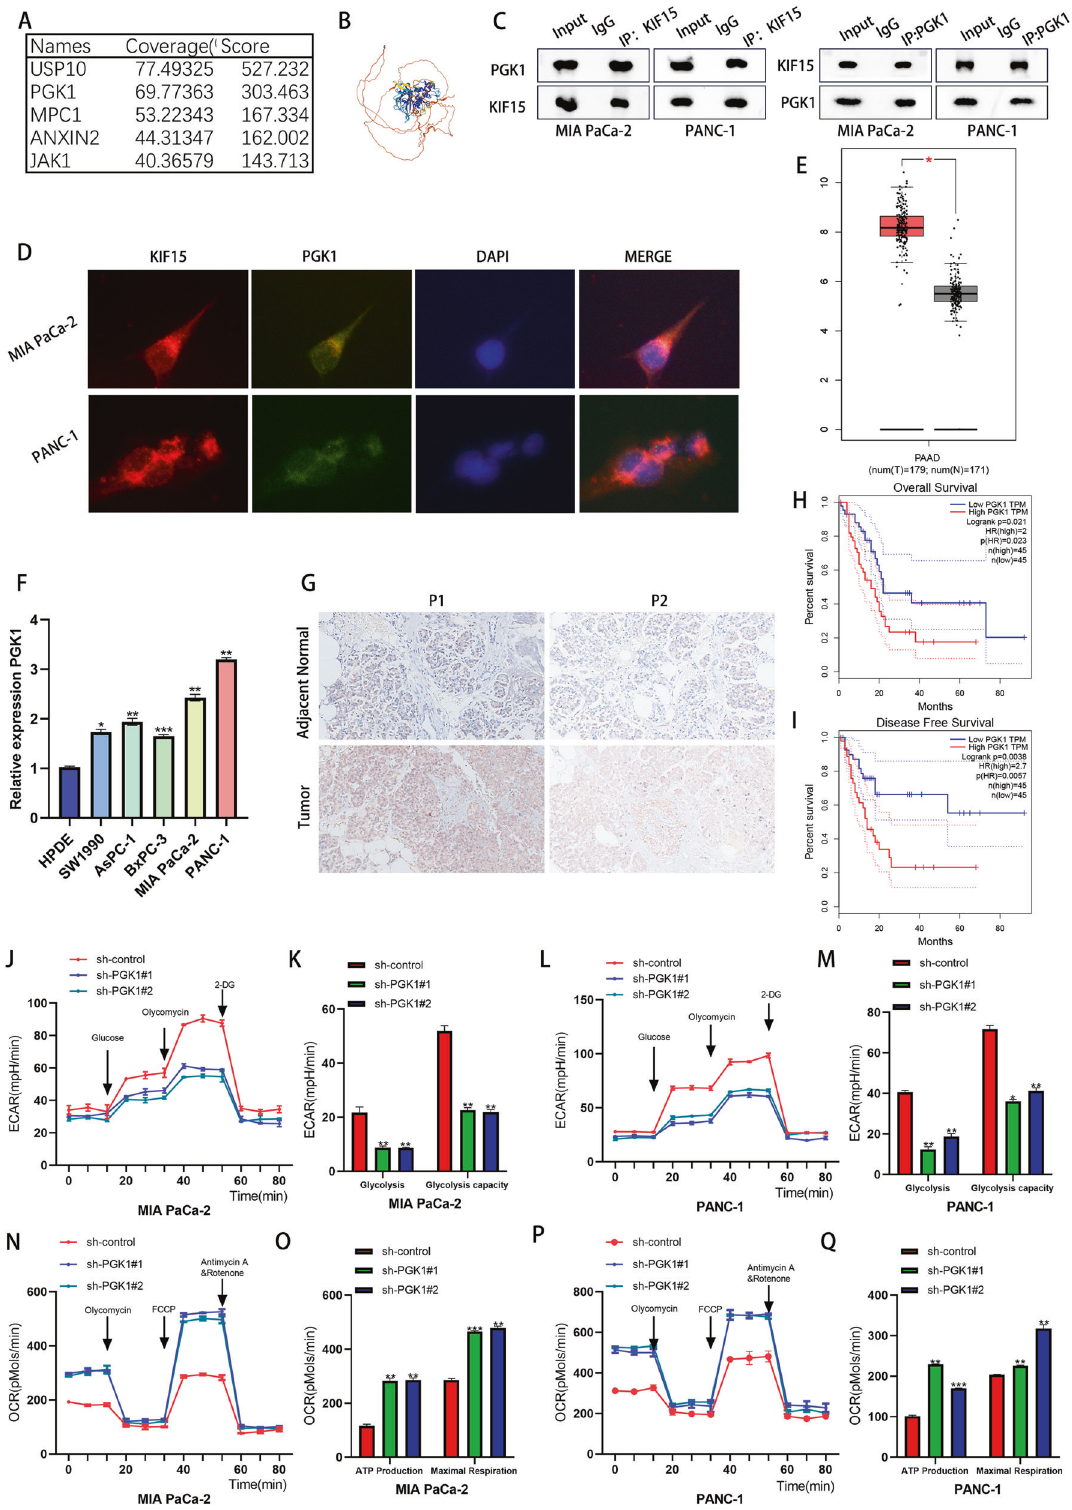
Fig. 4 KIF15 interacted with PGK1. A The mass spectrum showed the possible binding proteins of KIF15. B The predicted construction of PGK1 by bioinformatic tools (https://alphafold.ebi.ac.uk/). C The reciprocal co ‐ immunoprecipitation assay between PGK1 and KIF15. D The immuno fl uorescence between KIF15 (red) and PGK1 (green). E The expression of PGK1 in TCGA-PAAD dataset. F The relative expression of PGK1 mRNA in PC cells and normal pancreatic cells. G The IHC staining of PGK1 in PC patient tissues. n = 10. H The overall survival of patient in PGK1-low or PGK1-high expression group. n = 45. I The disease-free survival of PC patient in PGK1-low or PGK1-high expression group. n = 45. J , K The ECAR assay and quanti fi cation of Mia PaCa-2 cells transfected with PGK1 shRNA. L , M The ECAR assay and quanti fi cation of PANC-1 cells transfected with PGK1 shRNA. N , O The OCR assay and quanti fi cation of Mia PaCa-2 cells transfected with PGK1 shRNA. P , Q The OCR assay and quanti fi cation of PANC-1 cells transfected with PGK1 overexpression plasmids. Cell Death and Disease (2023)